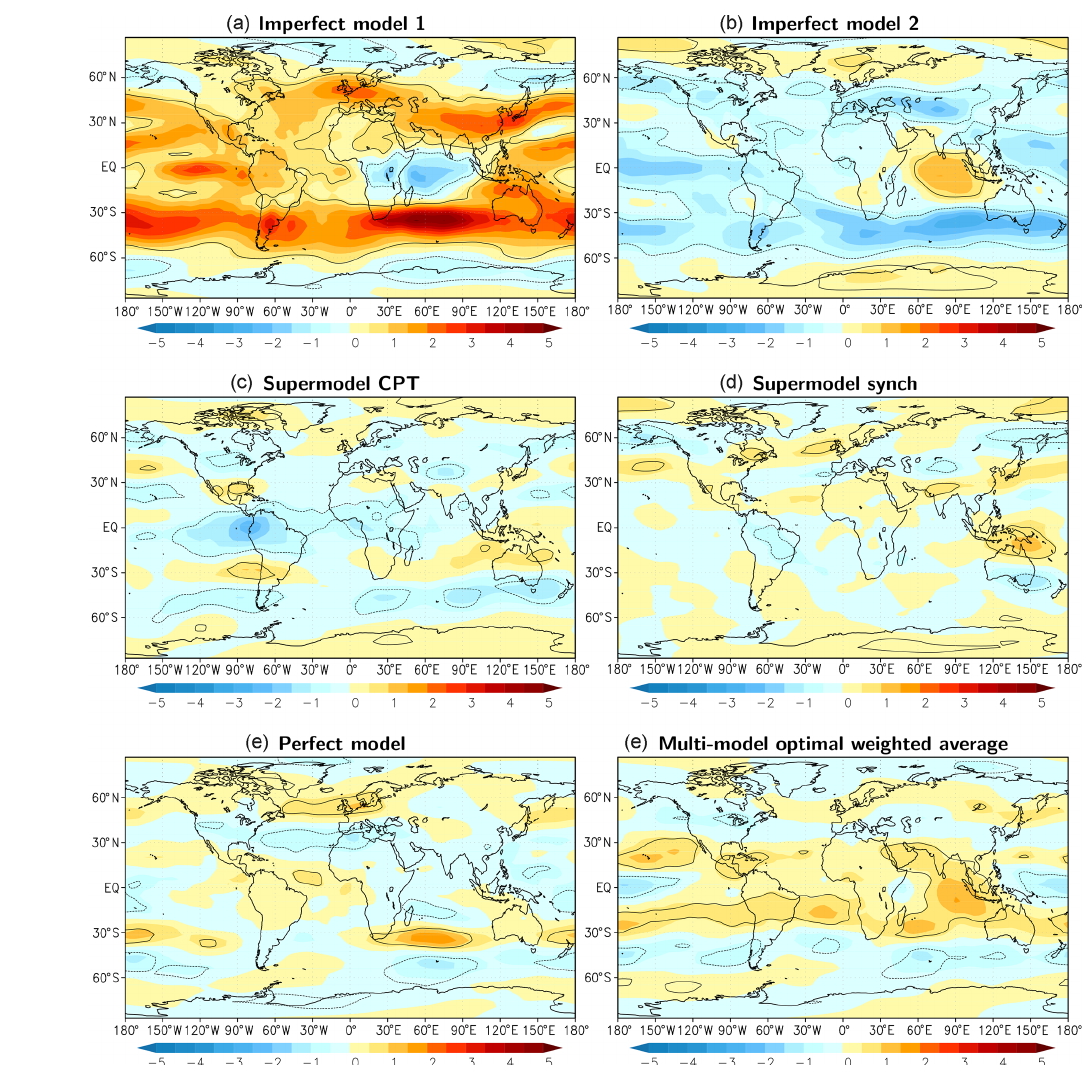
Figure 9. Difference in the zonal wind at 200hPa averaged over model years 2011–2040 for the various models with respect to the truth. Contours denote areas where the difference is larger than the sampling error at 95% confidence (solid for positive difference; dotted for negative). Positive values imply stronger mean winds blowing eastward. Units: ms − 1